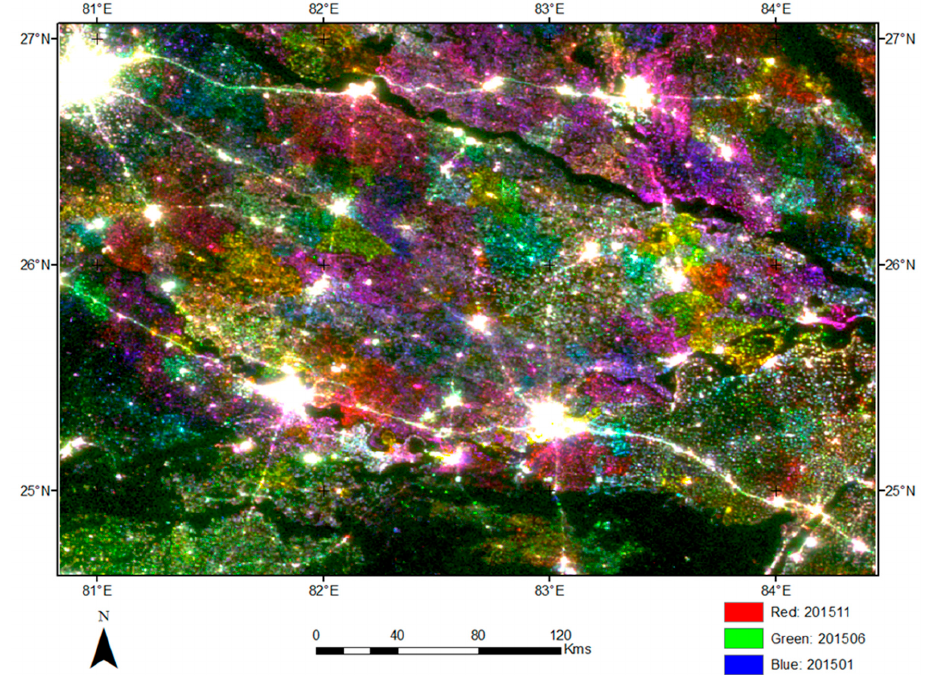
Figure 2. Jeweled carpet. Color composite of the monthly Visible Infrared Imaging Radiometer Suite (VIIRS) day / night band (DNB) cloud-free average radiance images of a portion of the Gangetic Plain, India. The color hues arise from the di ff ering level of radiances from the three months of data. January 2015 as blue, June 2015 as green, and November 2015 as